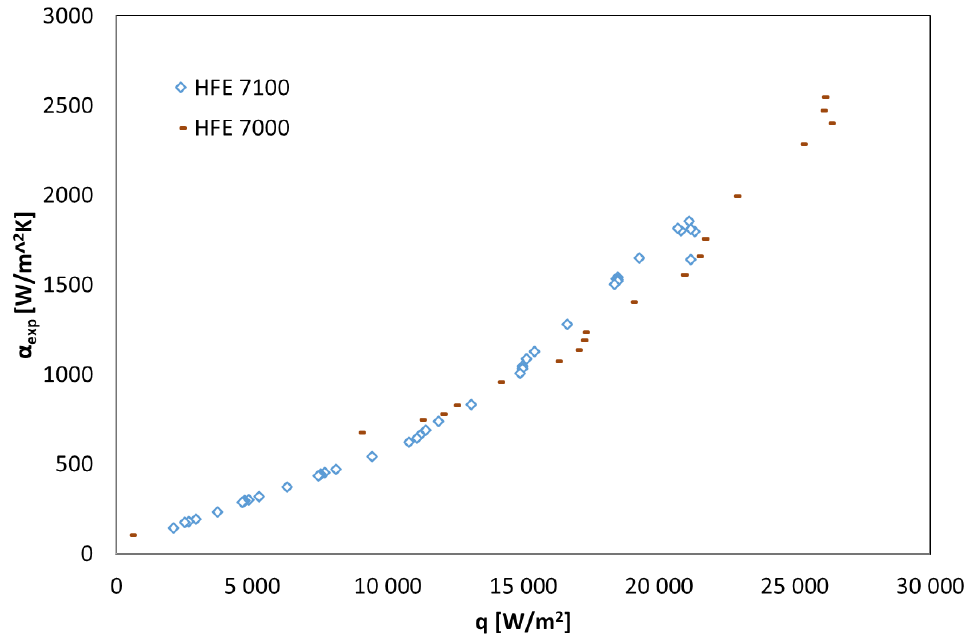
Figure 3. The dependence of the heat output of the shell-and-tube heat exchanger on the mean